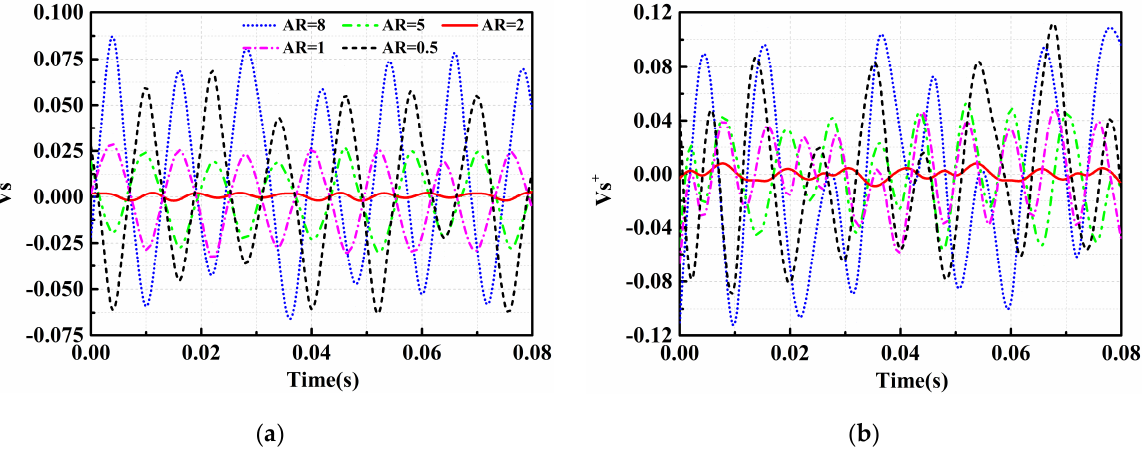
Figure 21. Time histories of the dimensionless vertical velocities at intersection point of groove centerline and horizontal line; ( a ) Re = 5.44 × 10 4 and ( b ) Re = 9.8 × 10 4 .